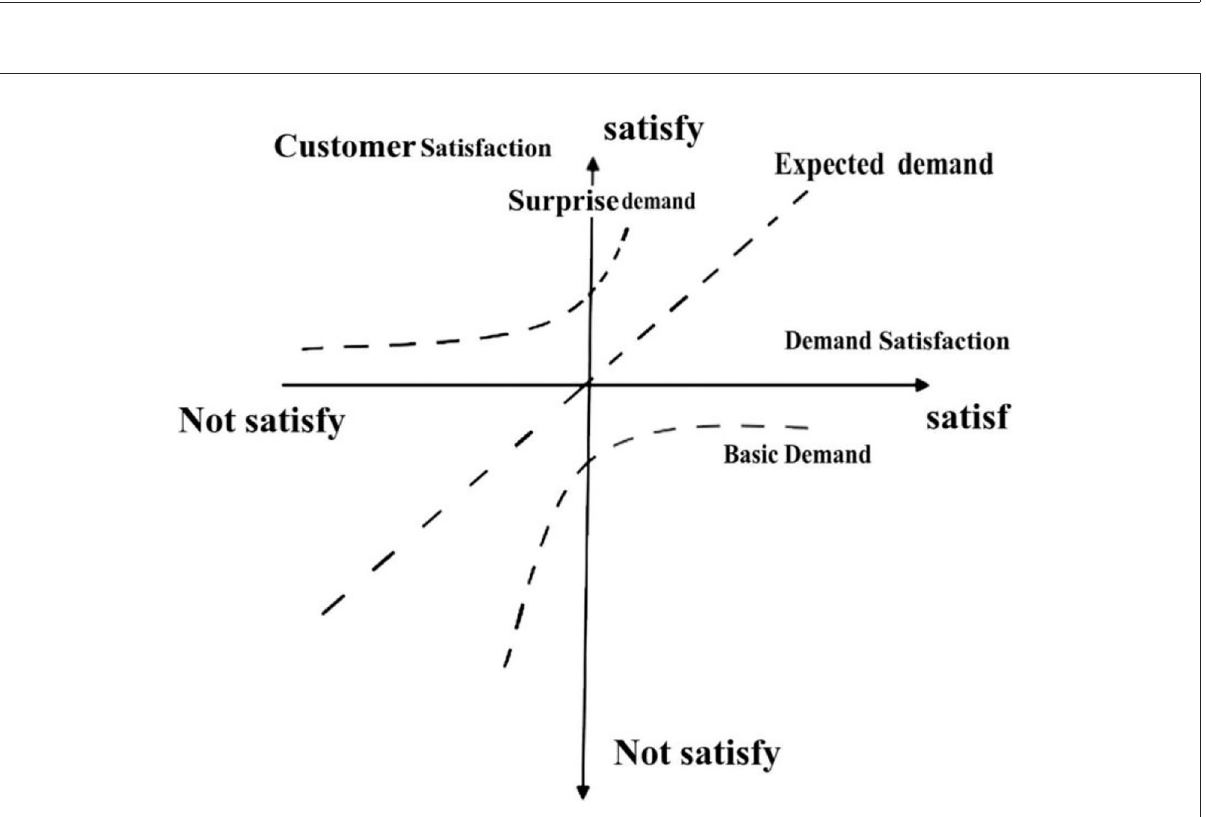
FIGURE9 Indicate customer demand